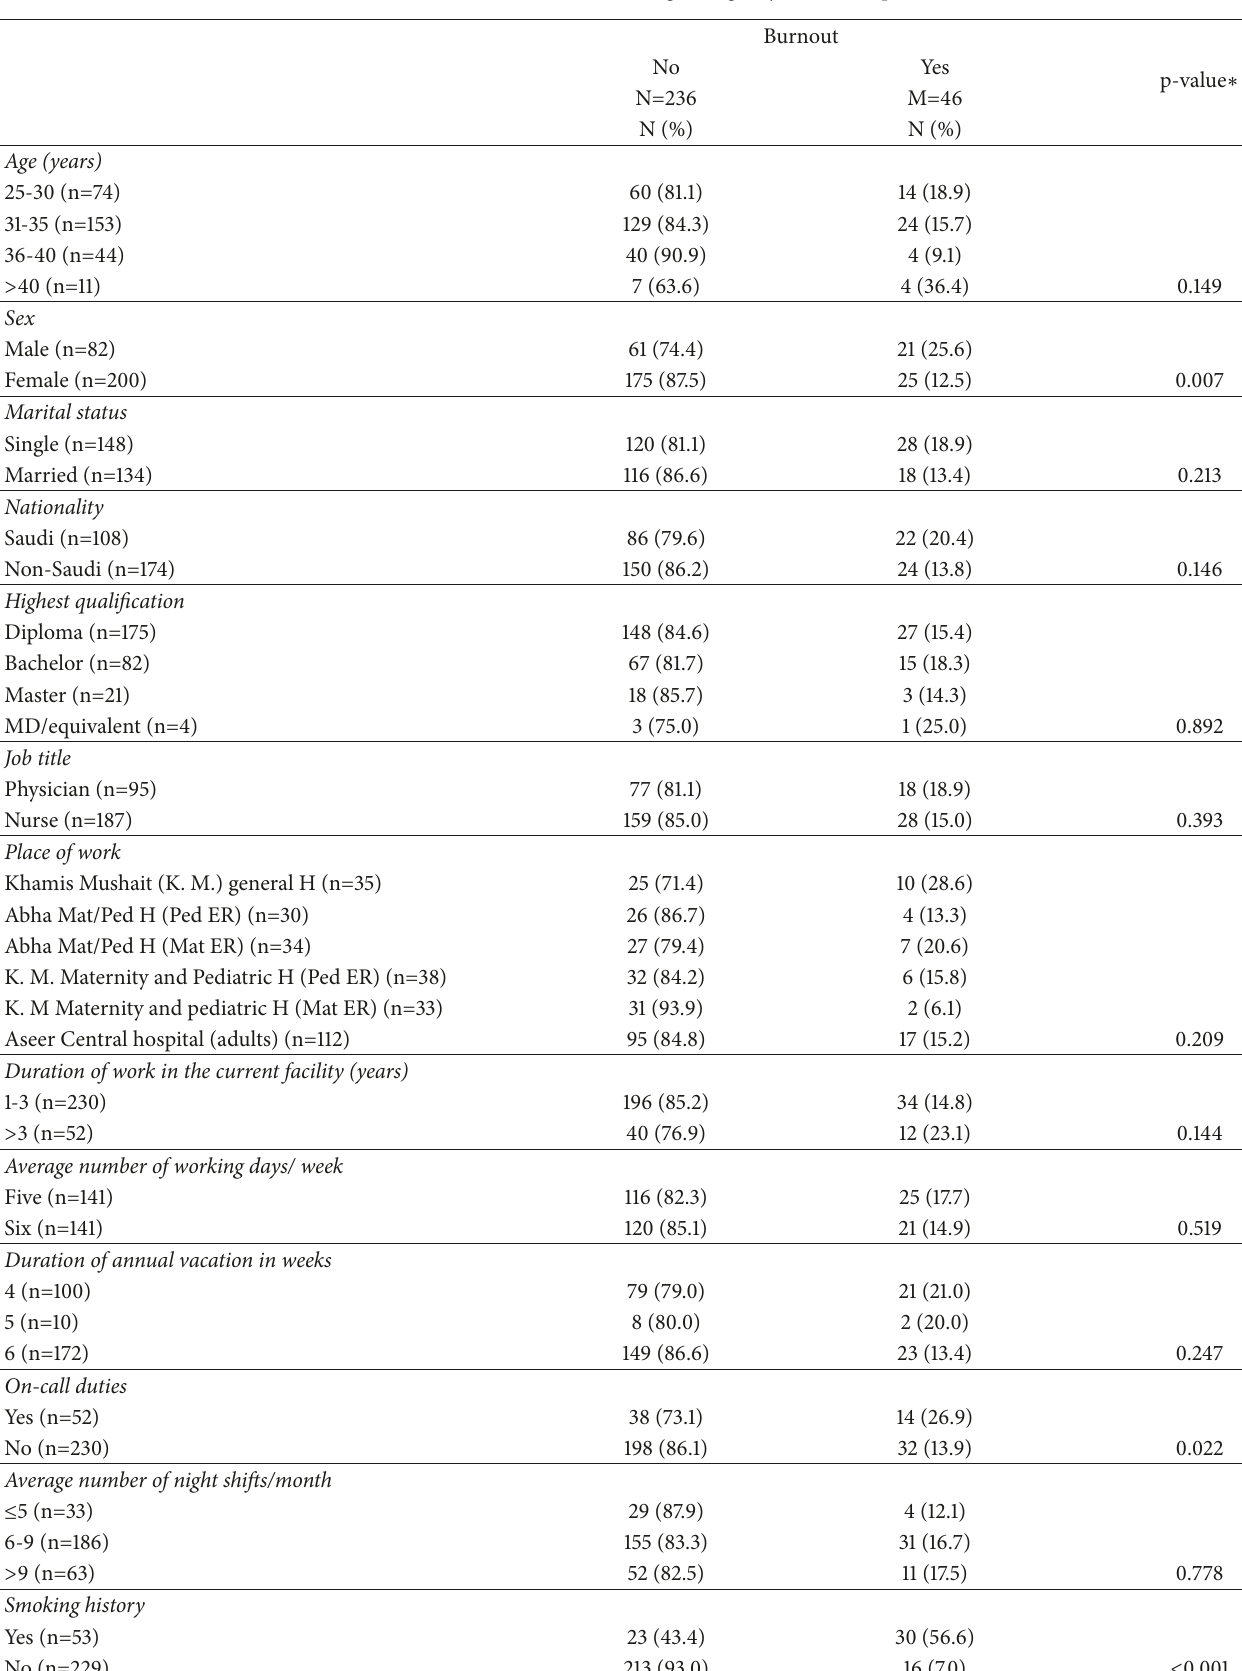
Table 6: Factors associated with burnout among emergency healthcare